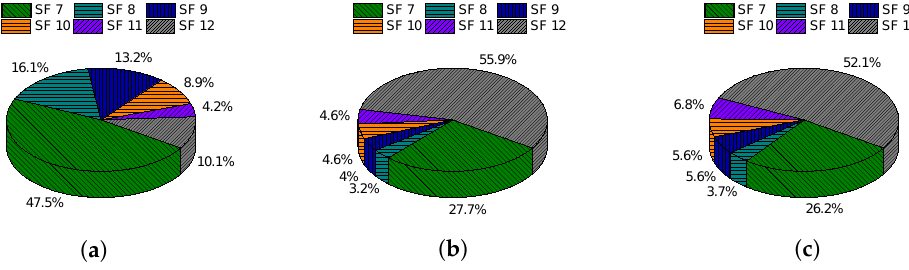
Figure 11. End devices using final spreading factors (in percentage) with N = 500 in the case of mobile EDs. ( a ) Proposed RM-ADR; ( b ) ADR; ( c ) G-ADR.